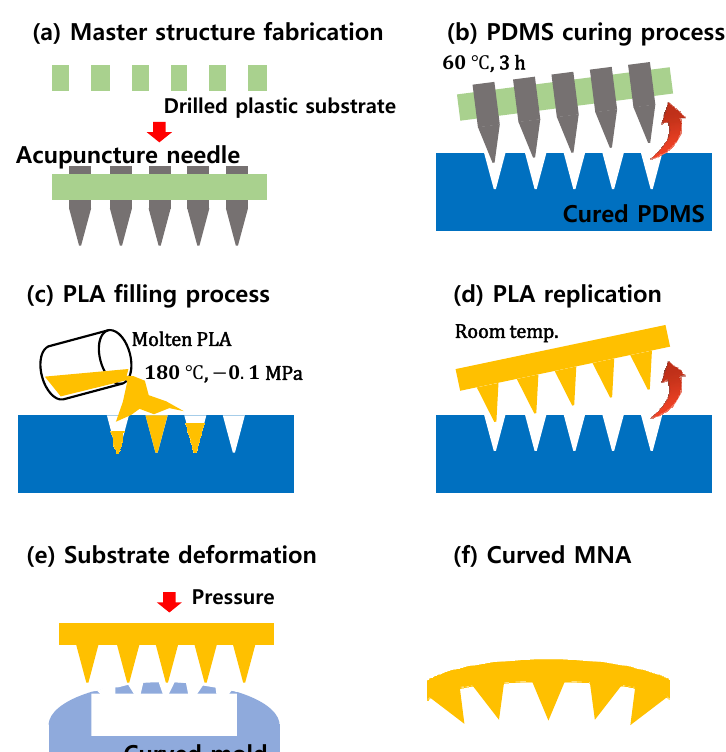
Figure 3. Fabrication process for the microneedle array. ( a ) Master structure fabrication with acupuncture needles; ( b ) PDMS mold fabrication using the master structure; ( c ) molten PLA filling process in a vacuum; ( d ) microneedle array replication; ( e ) substrate deformation on the curved mold; ( f ) fabricated curved microneedle